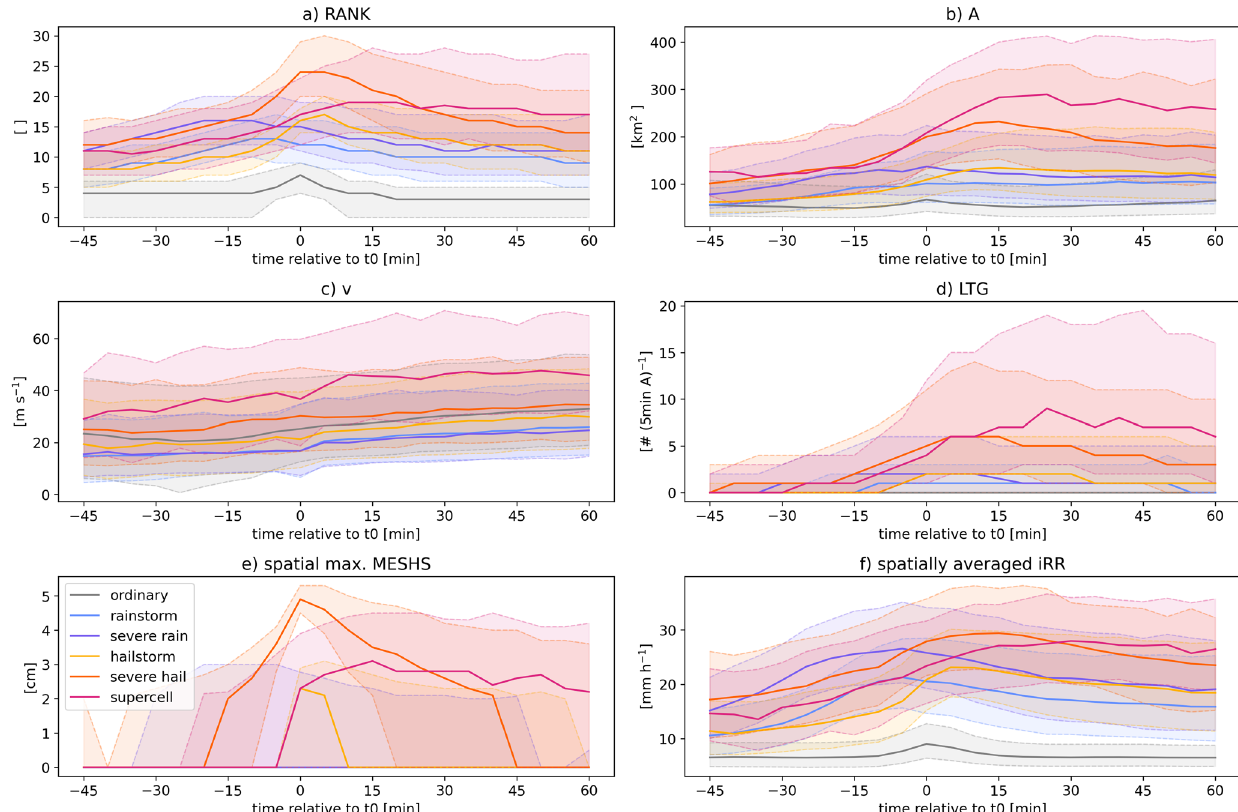
Fig. 4 Evolution of six variables during the 45 min leading up to and 60 min after the centre of the life cycle of each storm type. a Severity rank, b storm area, c translational speed, d lightning strikes, e maximum MESHS, f mean precipitation rate; the solid line depicts the median, while the shaded area represents the range of the 25th and 75th